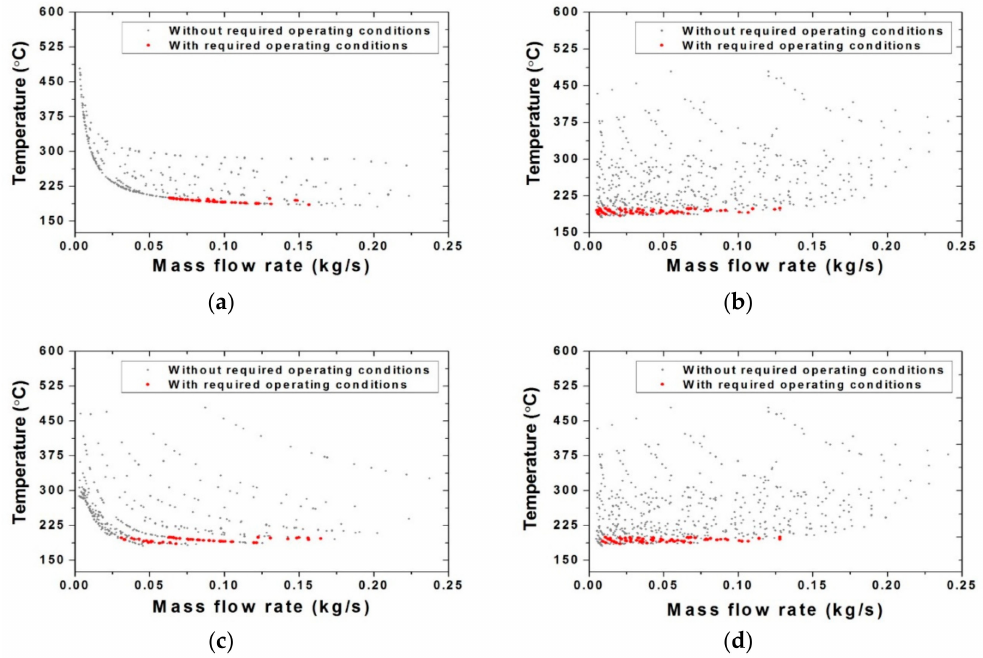
Figure 5. Stack outlet temperature according to flow rate of each valve (Absorption cooling capacity 2.0 kW). ( a ) TM valve; ( b ) IC valve; ( c ) CHP valve; ( d ) CCP